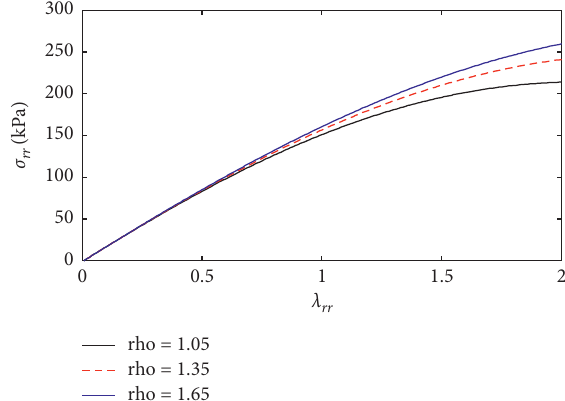
Figure 9: Study of the influence of the elasticity modulus on radial stress.